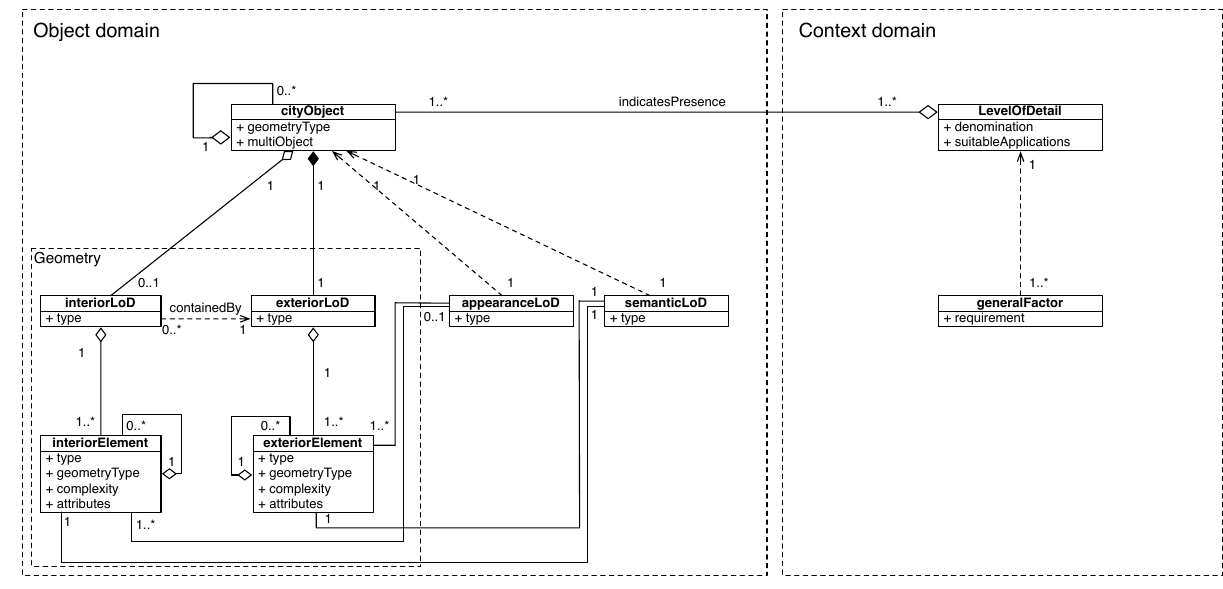
Figure 9: UML diagram showing the proposed framework for an LoD definition. The framework is separated into an object and a context domain, and the relation between LoDs, sub LoDs and their objects is